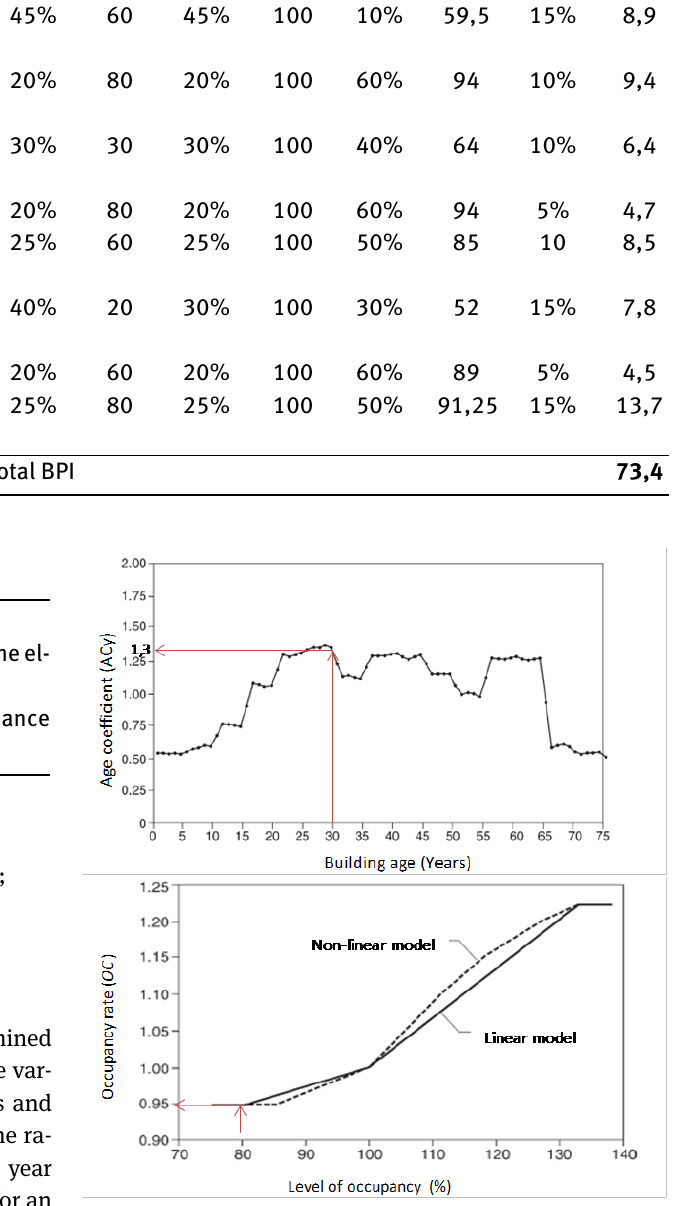
Figure 5: Determination of the age coeflcient and occupancy